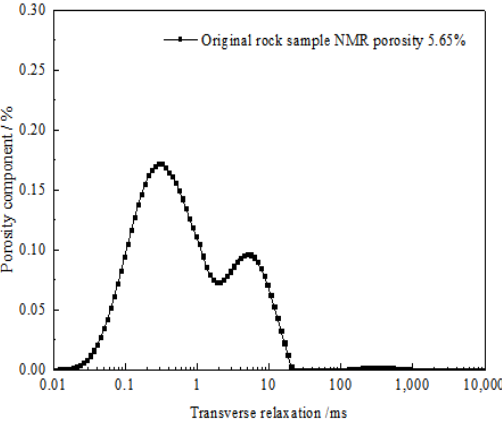
Figure 9. NMR T 2 spectrum of water-saturated rock sample (single peak to double peak).